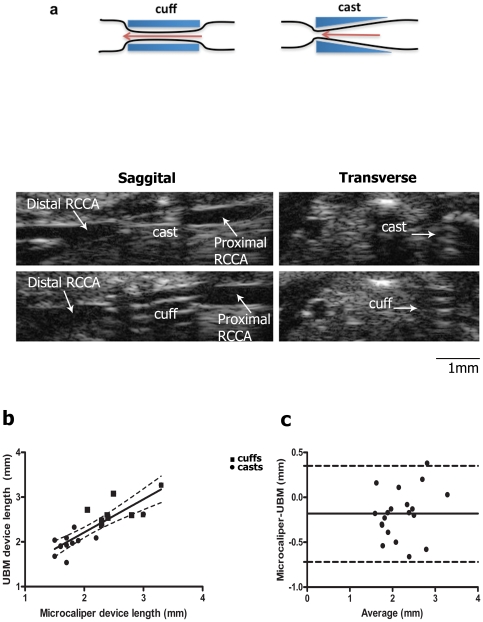
Implanted casts and cuffs produce a unique echogenic signature and their length can be precisely measured by ultrasound.Casts or cuffs were implanted around the right common carotid artery as described in Methods. (a) Representative sagittal and transverse B-mode ultrasound images of RCCA with cast or cuff 2 weeks post-surgery. Device length was measured from sagittal B-mode images or directly with microcalipers following fixation and the analyzed by (b) linear regression or (c) Bland-Altman Analysis. (b) Dotted lines indicate 95% confidence intervals. Correlation coefficient = 0.85; n = 20. (c) dotted lines: 95% limits of agreement. Bias, indicated by solid line, was calculated as -0.18 mm+/−0.27 SD.